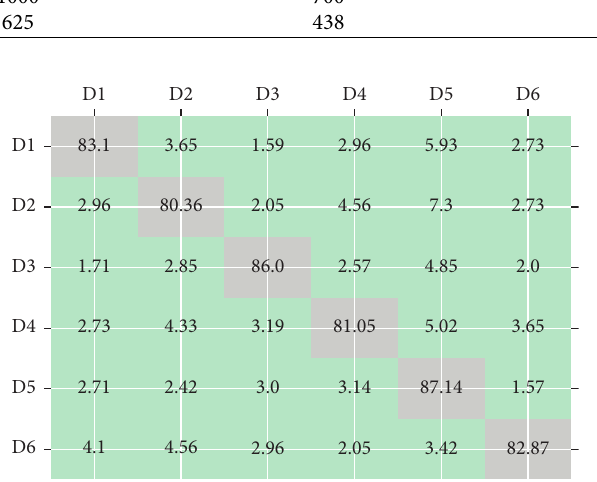
Figure 7: Confusion matrix of training dialect identification/dialect classification Table 6: Training performance of speaker identification system with different percentages of feature vectors having initial learning rate value � 0.1.